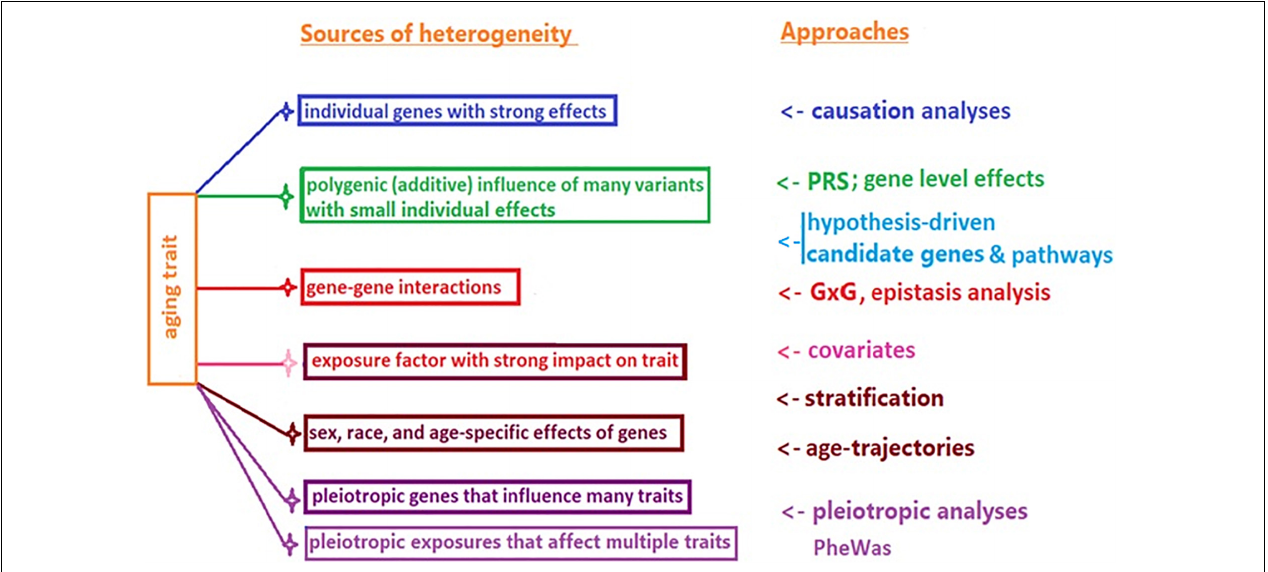
FIGURE 1 | Common sources of heterogeneity of aging and longevity related traits, and approaches to their